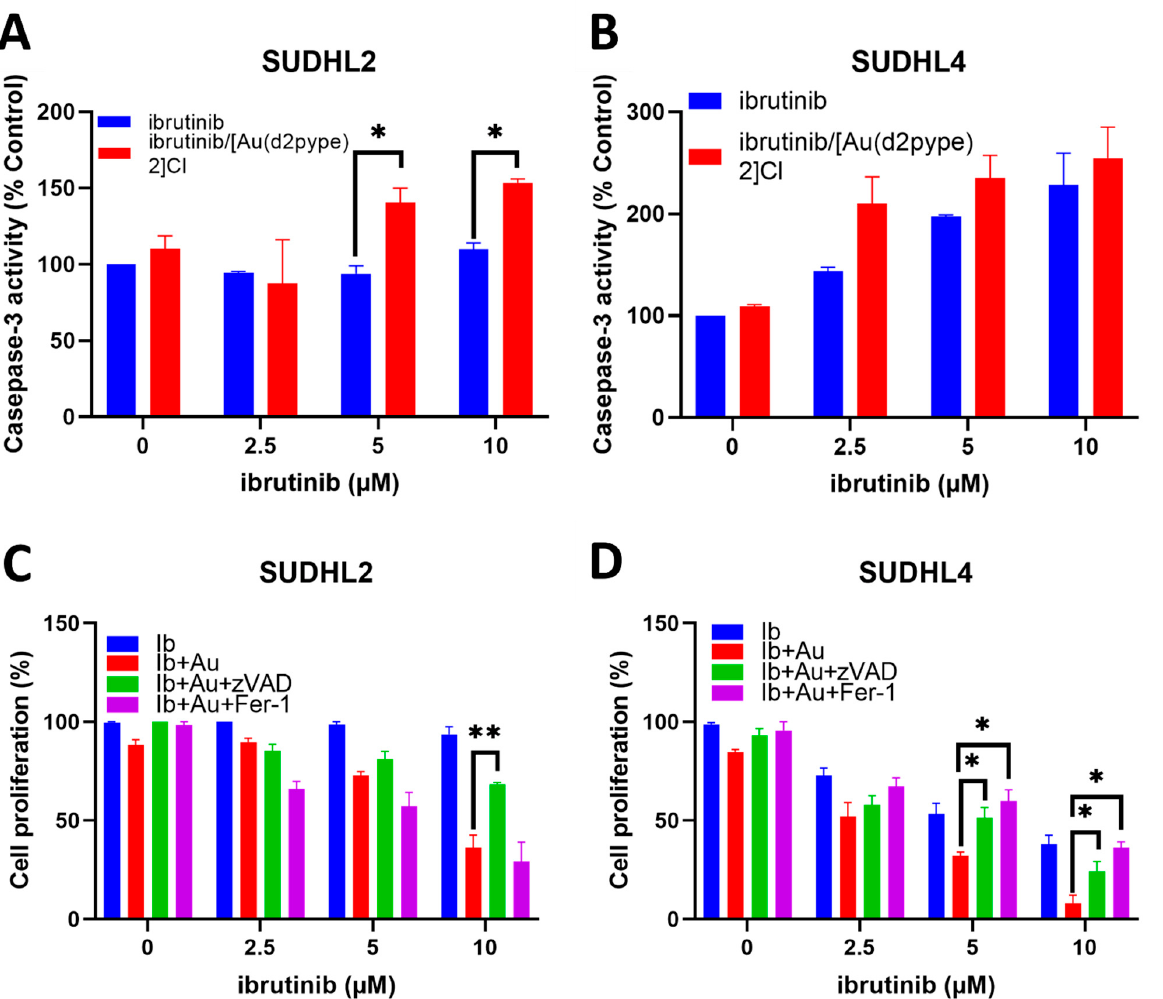
Figure 5. Caspase-3 activity and cell inhibition in DLBCL cell lines after treatment. ( A , B ), the two DLBCL cell lines were treated with the indicated concentrations of ibrutinib with or without [Au(d2pype) 2 ]Cl for 24 h. ( A ) SUDHL2 and ( B ) SUDHL4 cells were cotreated with 0.25 µ M of [Au(d2pype) 2 ]Cl. ( C , D ), lymphoma cells were treated with the indicated concentrations of ibrutinib with or without [Au(d2pype) 2 ]Cl plus 25 µ M zVAD-fmk, or 10 µ M Ferrostatin-1 for 24 h. Significance levels are marked as * p < 0.05 and ** p <